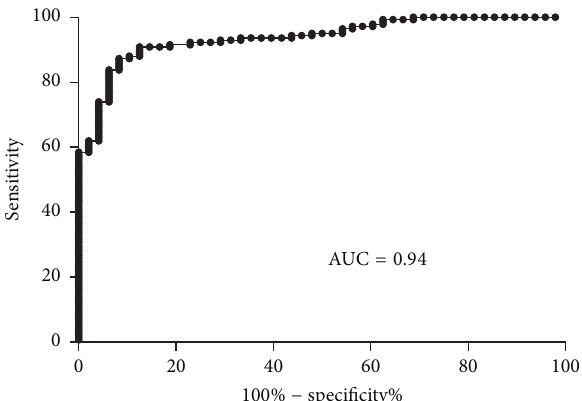
Figure 3: ROC curve analyses. The miR-203 ROC curve was establishedtodiscriminatepatientswithGERD( 𝑛 = 142 )fromCtrls ( 𝑛 = 48